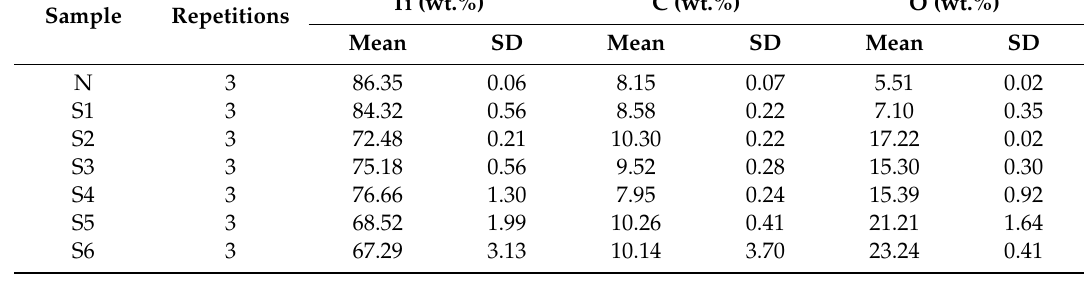
Table 2. Results of energy-dispersive X-ray spectroscopy (EDS) analysis of non-treated surface (N) and machined surface (S1–S6).